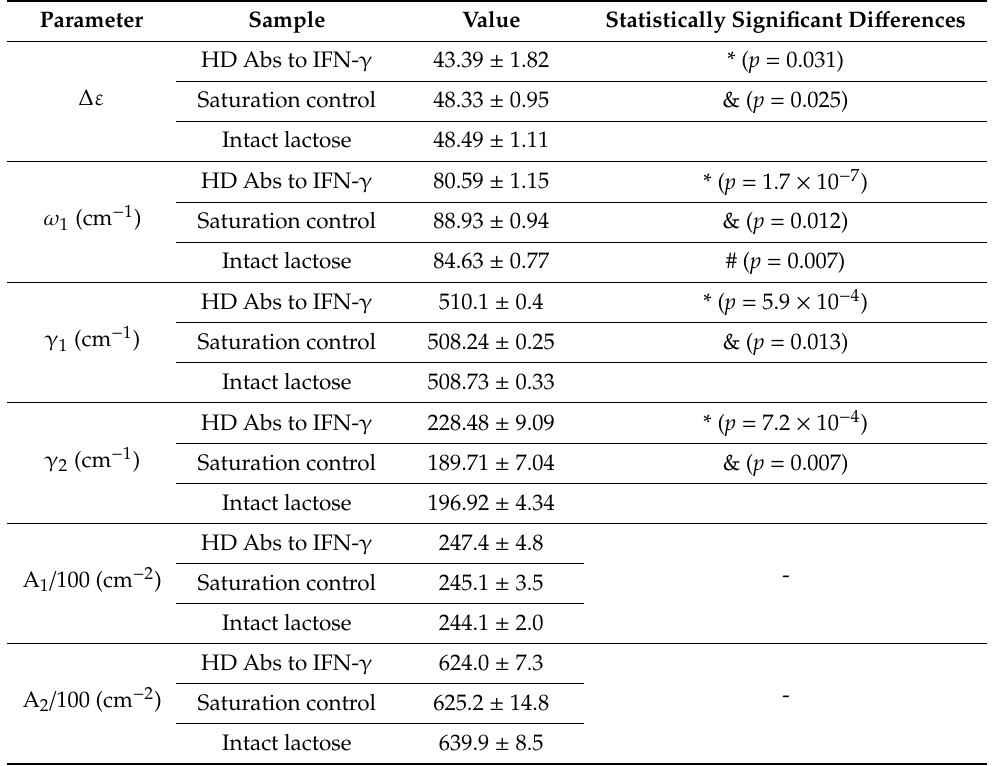
Table 1. Results of terahertz time-domain spectroscopy data analysis: values of the calculated parameters of model (4) 1 .